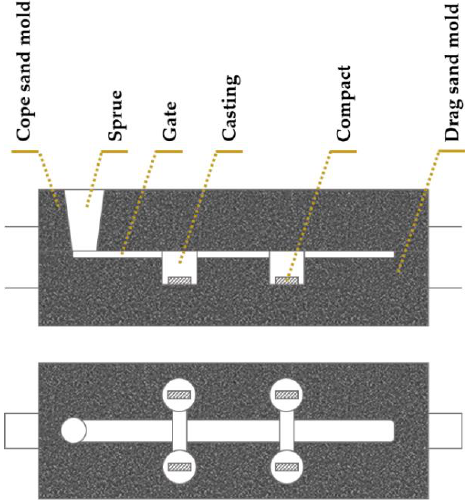
Figure 2. Schematic view of the positioning of the compacts in drag mold (front and top views).